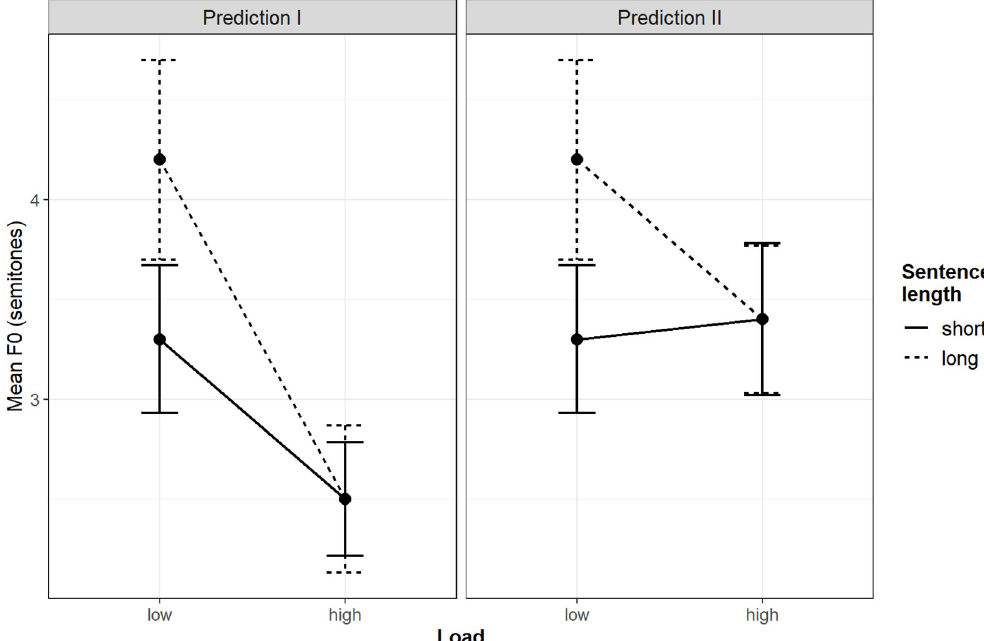
Fig 1. Illustration of hypotheses regarding sentence-initial intonation peaks based on the invented data. Error bars indicate the 95% confidence intervals.